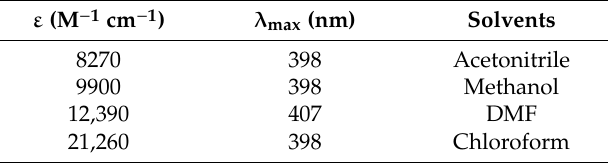
Table 1. Molar extinction coe ffi cients ε in di ff erent solvents for the cu-complex